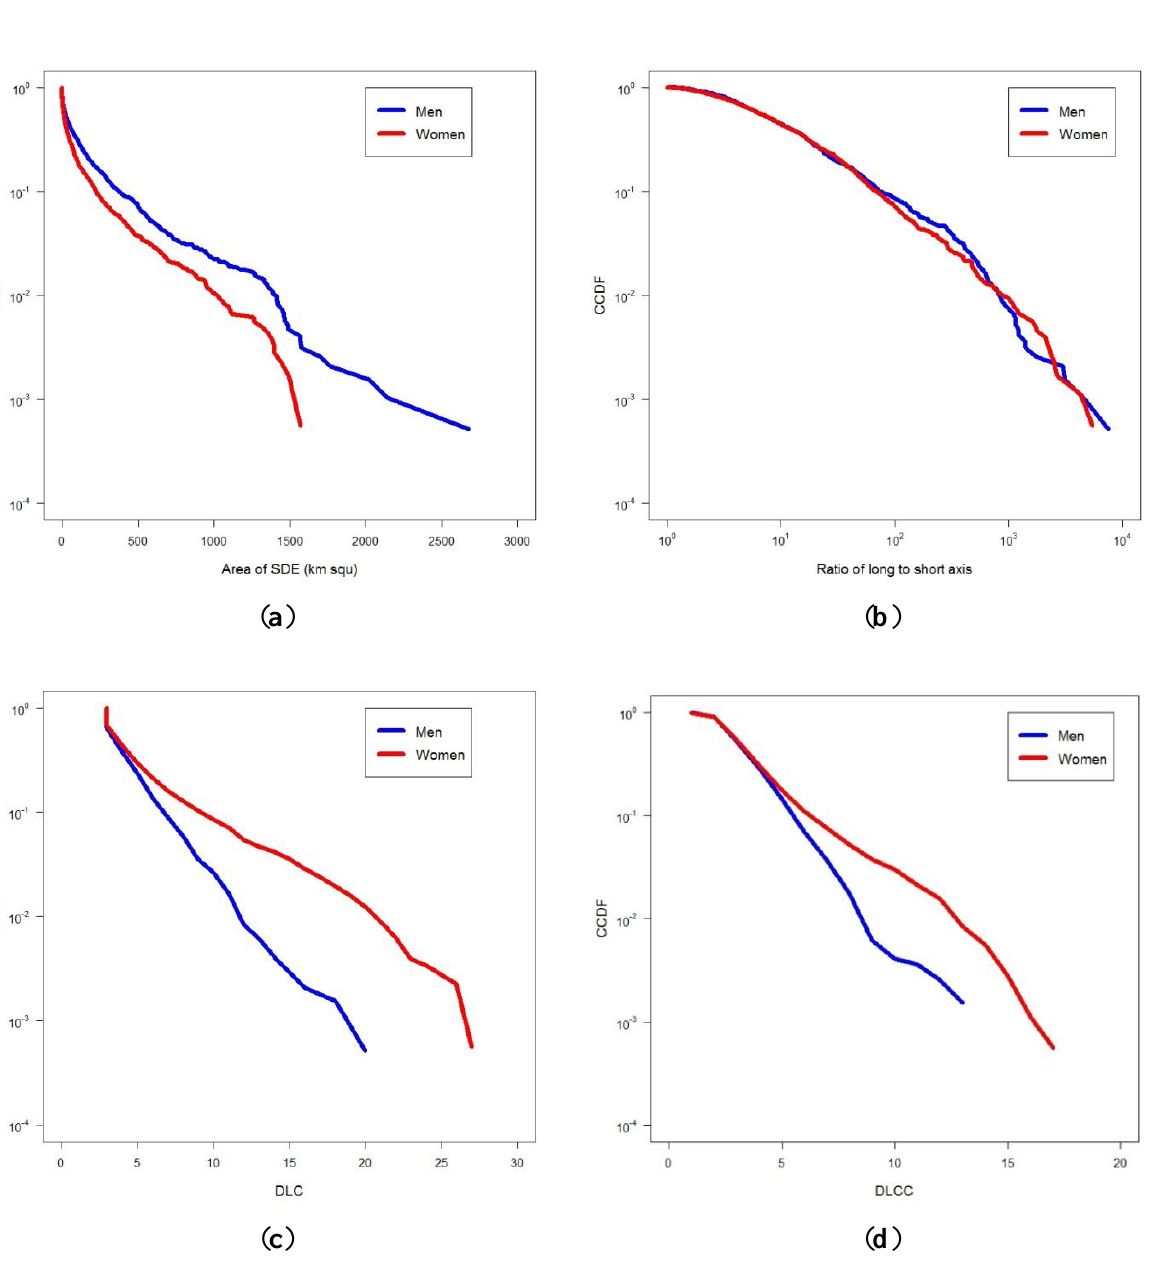
Figure 3. CCDFs of the four indicators for male and female users in log-linear plots and log-log plots. (a) Area of SDE; (b) ratio of long to short axis; (c) DLC; (d)